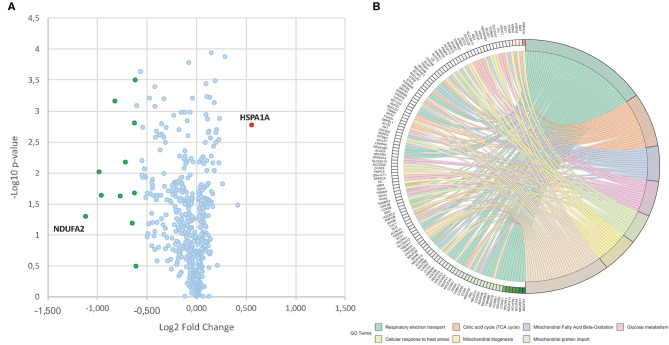
(A) Volcano plot obtained from TMT-based quantitative proteomic analysis of MC2494-treated vs. untreated U937 cells. Each point represents the difference in expression (log2 fold change) between MC2494-treated vs. untreated samples plotted against the –log10
p-value. Identified proteins with no changes in their regulation level are in light blue. Up- and down-regulated proteins (0.6≥ fold change ≥1.5) are shown in red and green, respectively. (B) GOChord plot showing relationships between selected representative biological process GO terms and related proteins identified by nanoLC-MS/MS analysis. The red and green color scale within the plot refers to protein log2 fold change values.